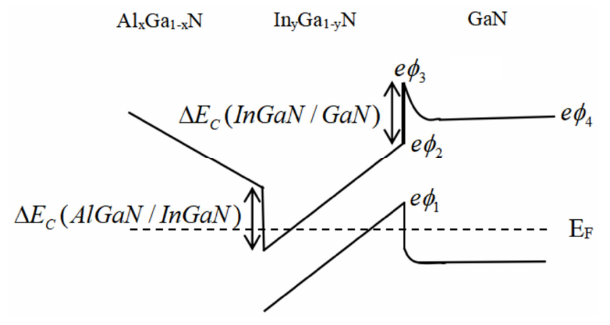
Figure 9. Band structure diagram of AlGaN/InGaN/GaN HEMT.